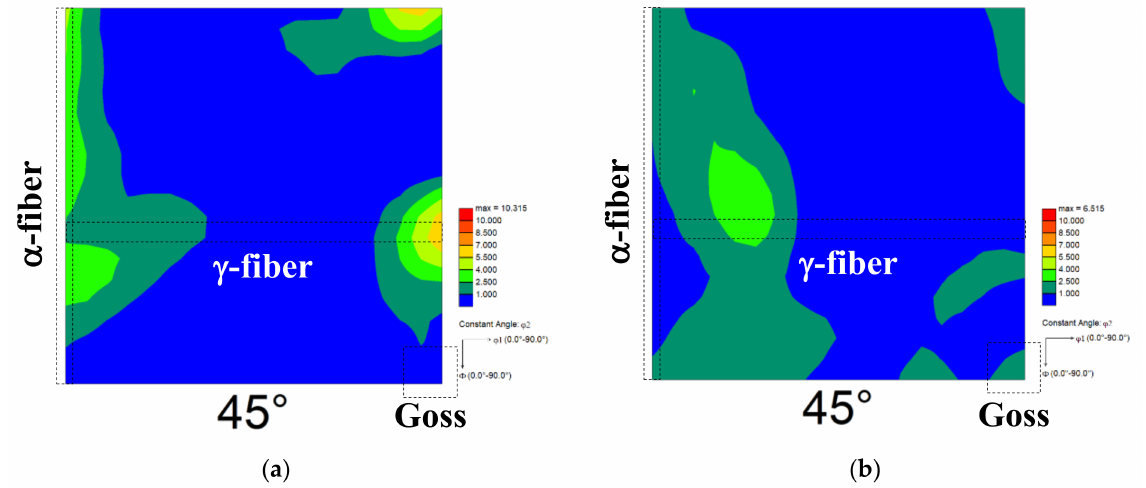
Figure 4. Global texture for specimens annealed at 723 K for ( a ) 10 s and ( b ) 15 s ( ϕ 2 = 45 ◦